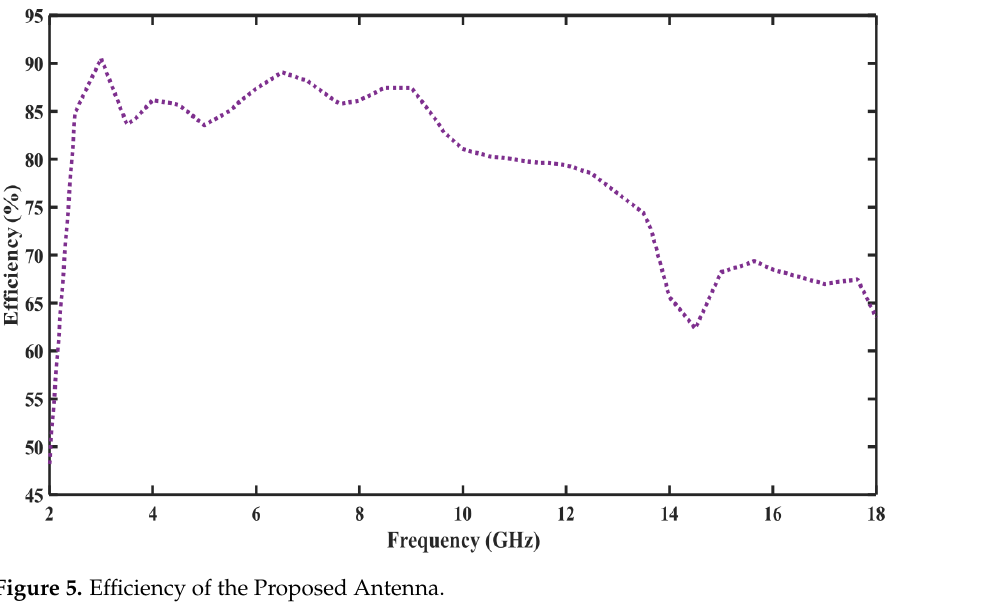
Figure 5. Efficiency of the Proposed Antenna.